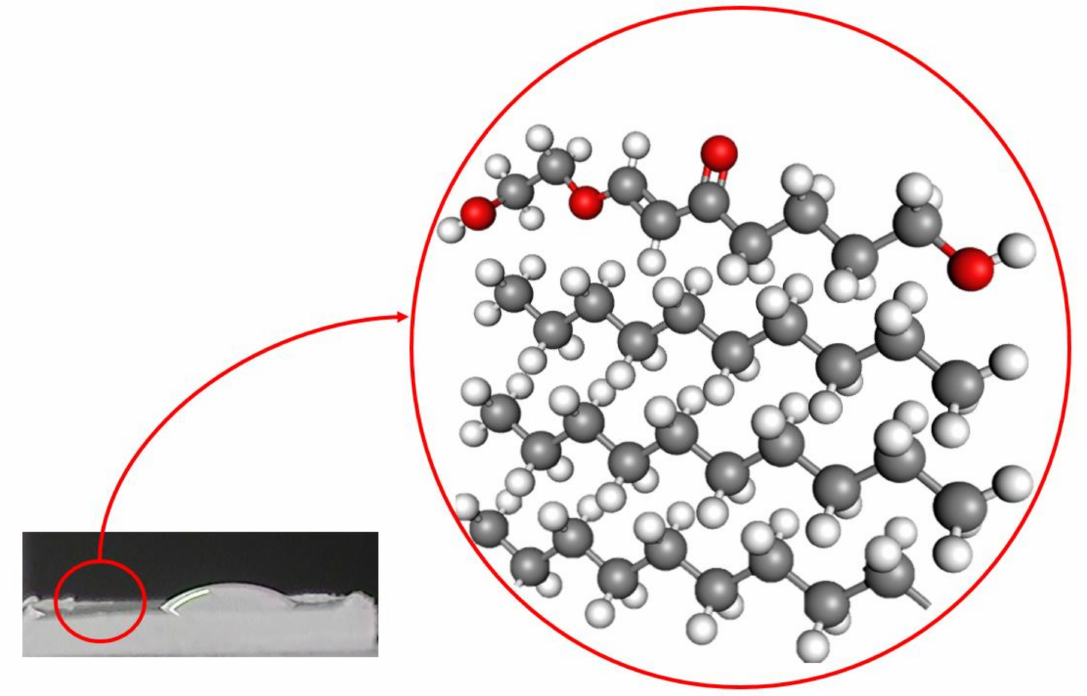
Figure 12. HDPE surface modification by plasma DBD